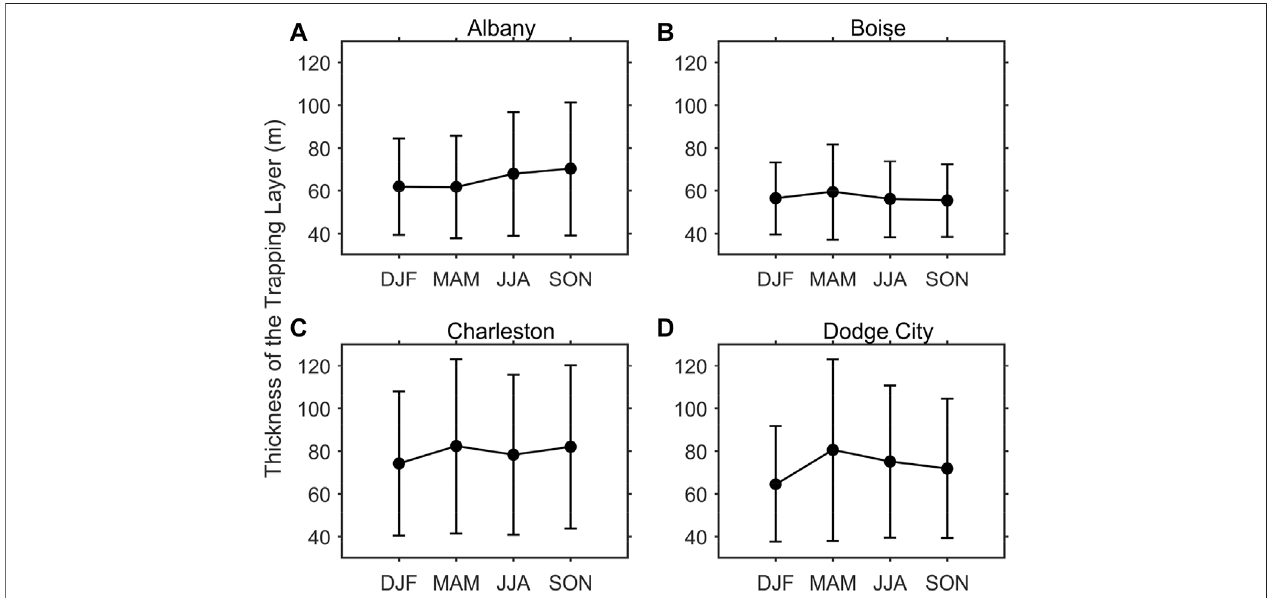
FIGURE9| Seasonalvariationofthethicknessofthetrappinglayeroverthefourstations. (A – D) Albany,Boise,CharlestonandDodgeCity.Theverticalbarsarethe standard errors.